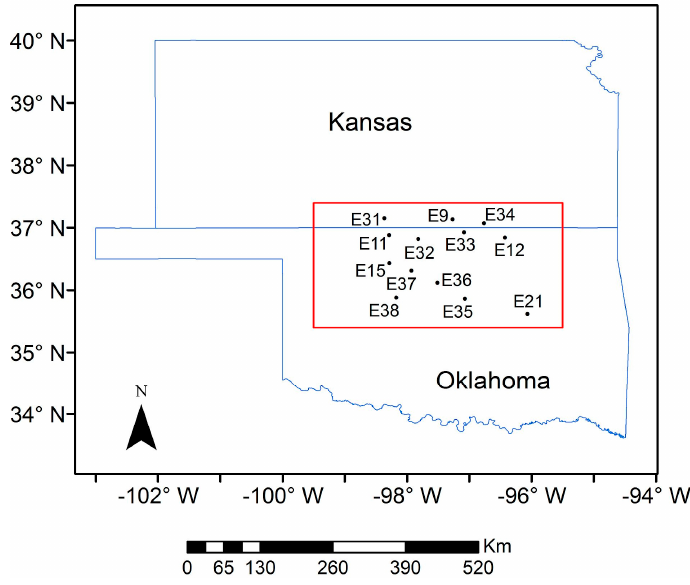
Figure 1. Atmospheric radiation measurement (ARM) ground sites within the Southern Great Plains (SGP) in Oklahoma and Kansas. The red box shows the SGP domain for this